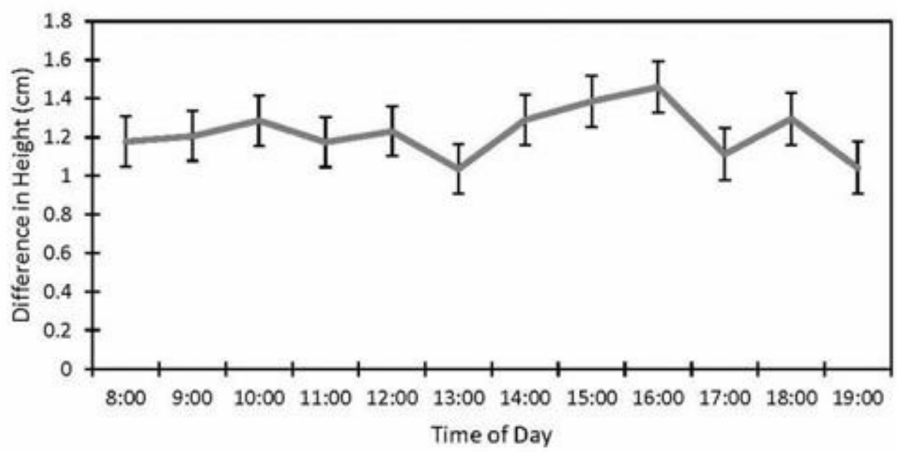
Figure 6. Effect of time of day on accuracy of image height estimates (estimate ± SE) from data collected at study sites located at the Utah Test and Training Range (UTTR) in northwest Utah.